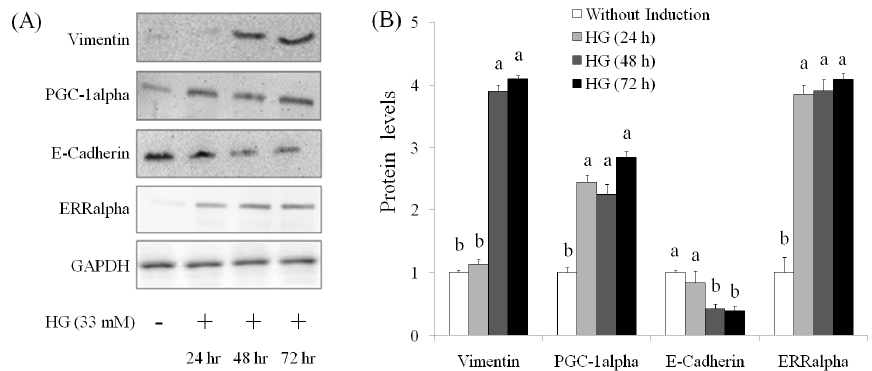
Figure 4. The effects of high glucose induction on ( A ) EMT markers by Western blot and ( B ) the results of quantity analysis in OVCAR-3 carcinoma cells. Data were shown as mean ± SD ( n = 3). A significant difference between groups ( p < 0.05) is shown by different letters.